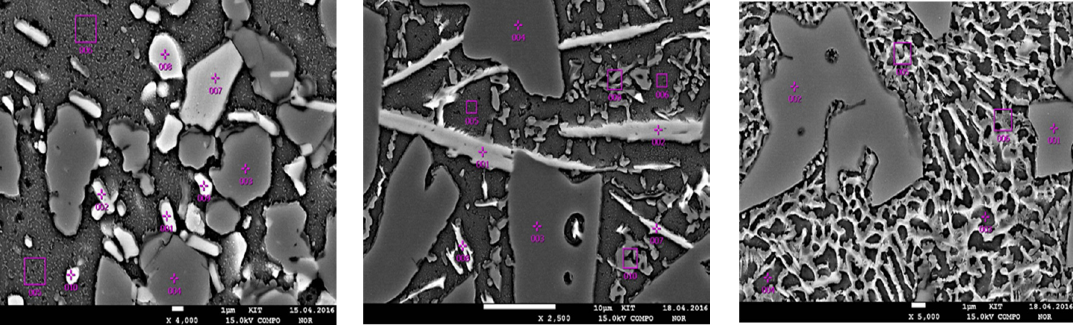
Figure 6. S225. ( a ) Base material; ( b ) Transition of weld seam to base material; ( c ) Center of the weld seam for v = 0.5 m/min; ( d ) Center of the weld seam for v = 10 m/min.